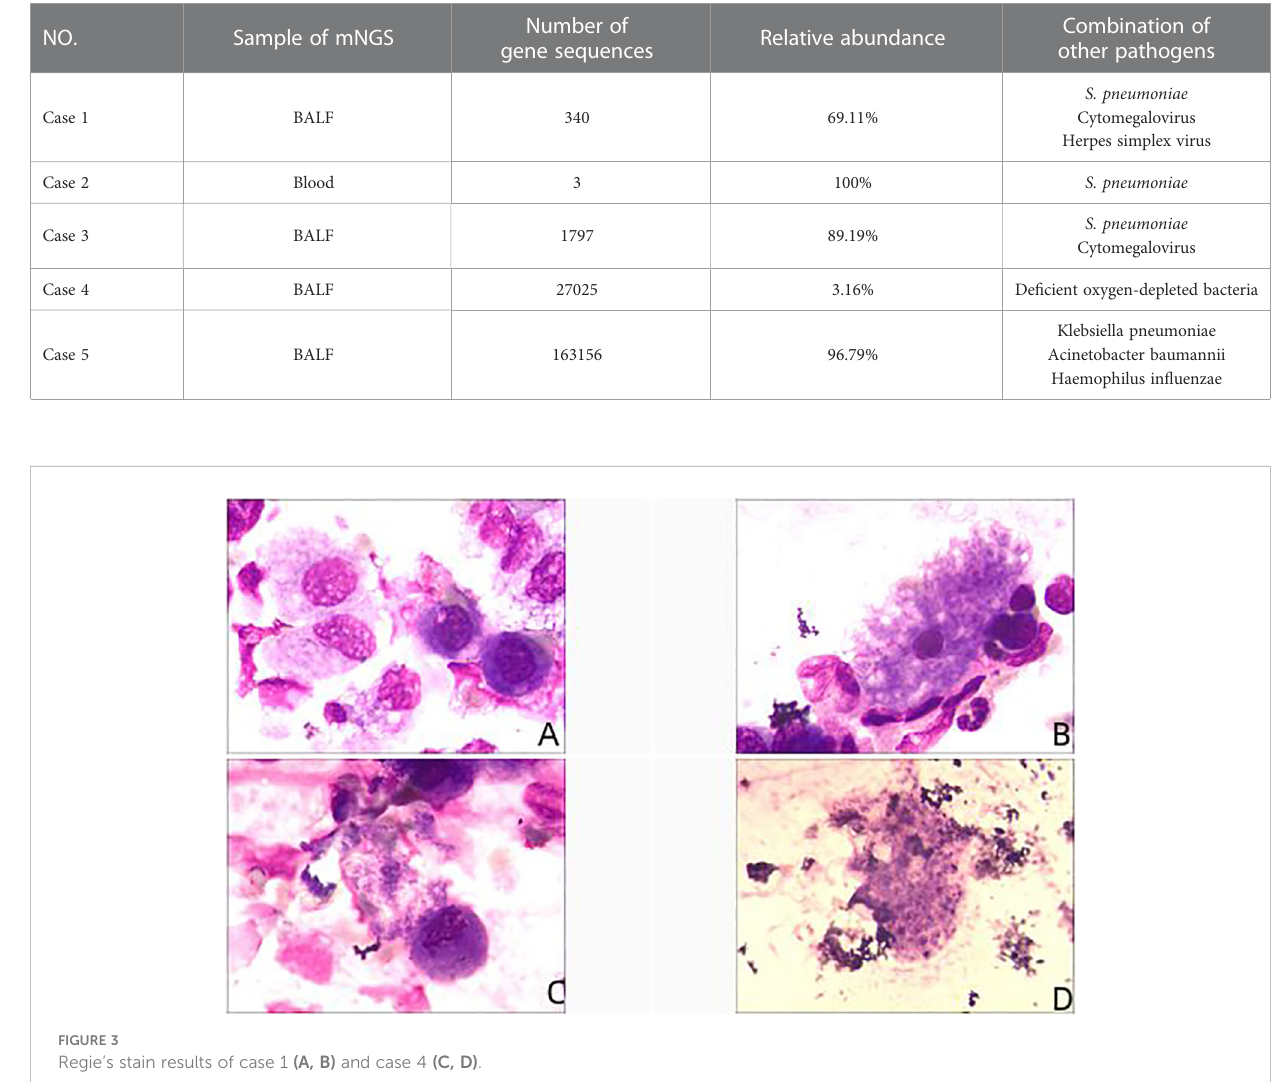
TABLE 2 Results of mNGS in fi ve children.